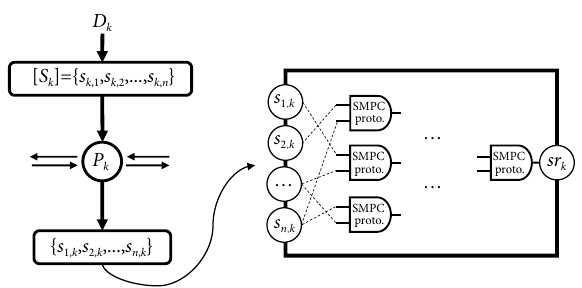
Fig. 2 The process of generating and allocating secret shares in the initial- ization phase: a three-agent example.